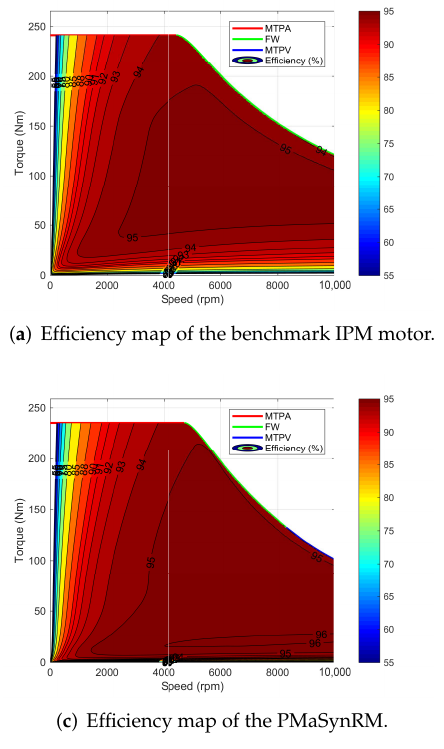
Figure 15. Comparison of the efficiency maps of the three